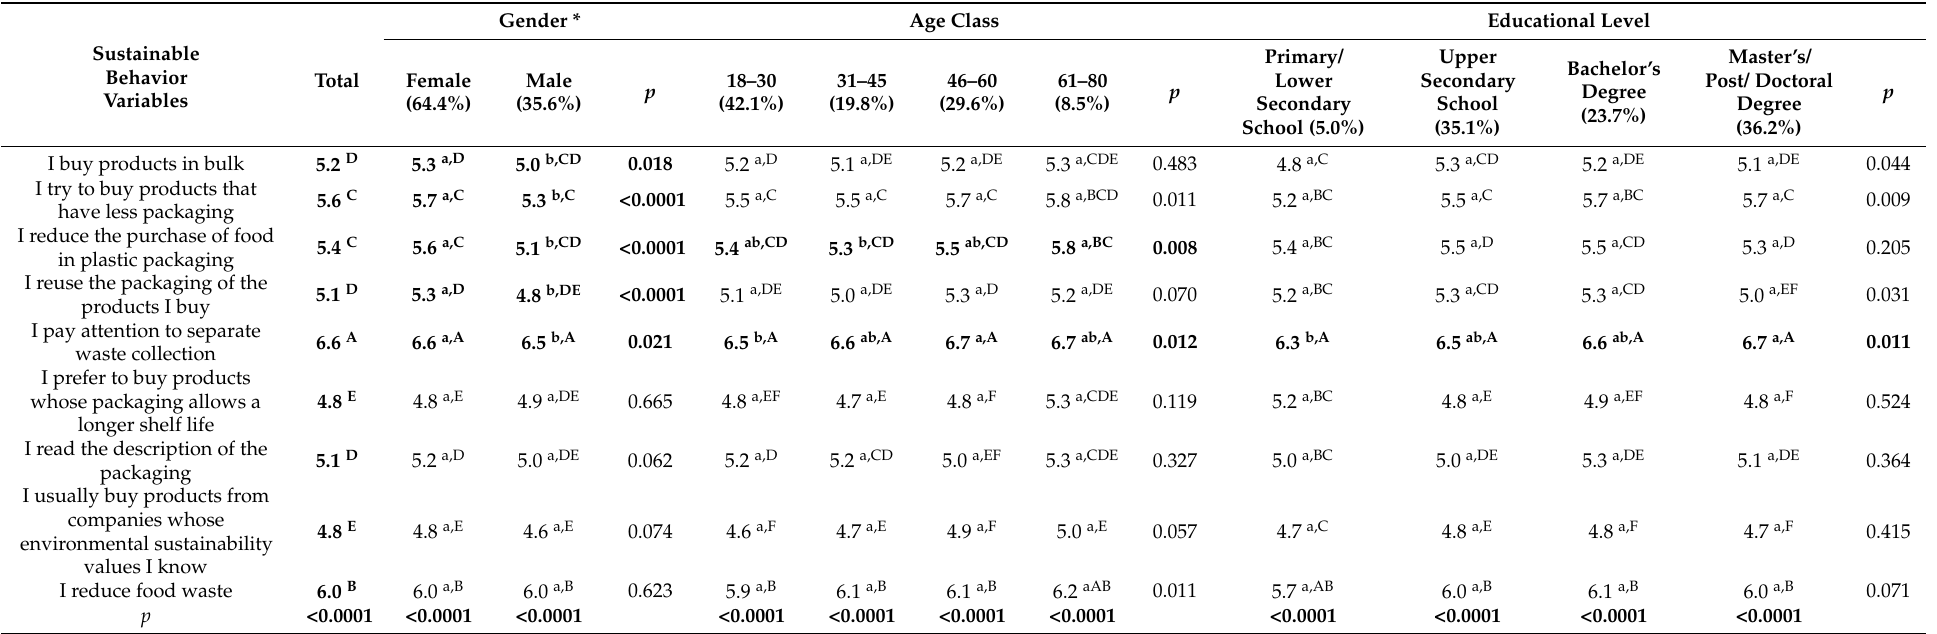
Table 2. Effect of socio-demographic characteristics on consumer behavior ( n =